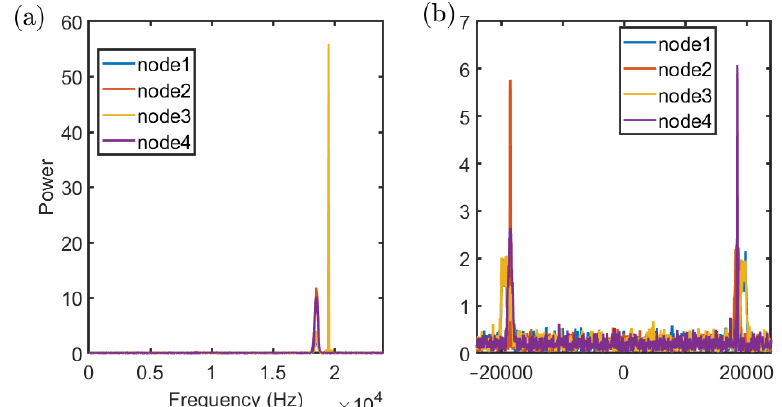
Figure 16. Results of STFT ( a ) and FrFt ( b ) with 4 nodes. Node 1 is an 18 kHz – 19 kHz Chirp signal, superimposed with a 19,500 Hz single-frequency signal. Node 2 is an 18 kHz – 19 kHz Chirp signal. Node 3 is a 19 kHz – 18 kHz Chirp signal, superimposed with a 19,500 Hz single-frequency signal. Node 4 is a 19 kHz – 18 kHz Chirp signal.